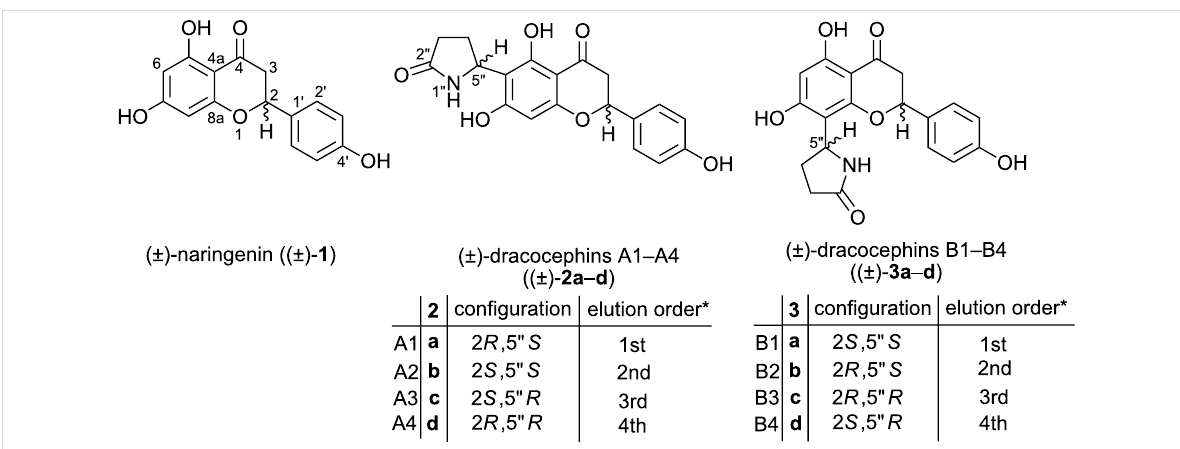
Figure 1: Structures of (±)-naringenin, (±)-dracocephins A1–A4 and B1–B4 with the indication of the absolute configuration and elution orders for sep- aration on Chiralpak AS-H* column [2]. The absolute configurations are presented as proposed by Ren et al. [2].